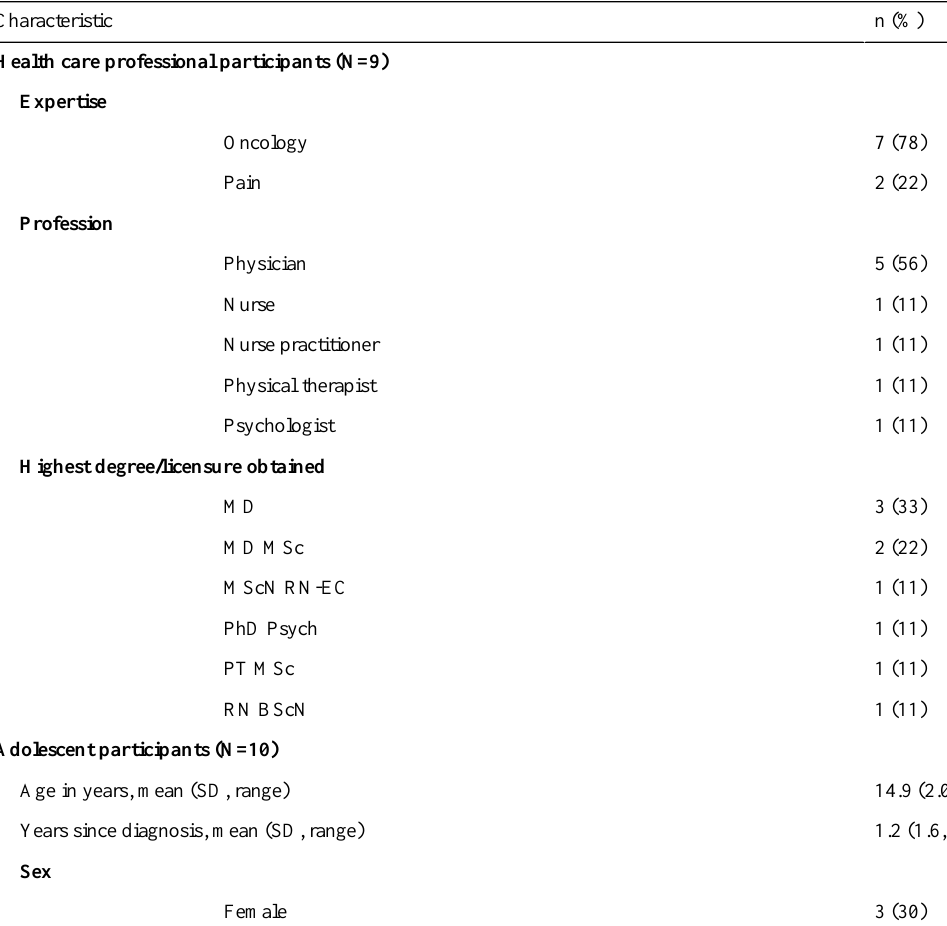
Table 2. Qualitative interviewing participant